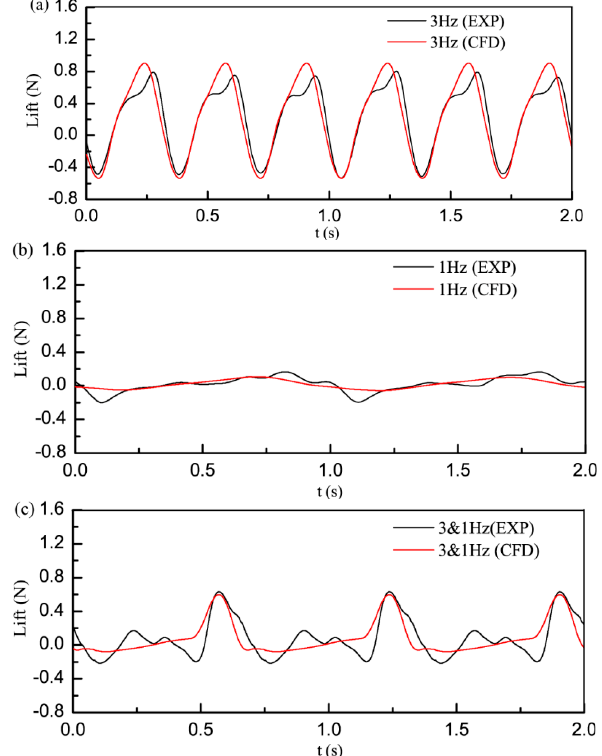
Figure 13. Lift force comparison between the experiment and CFD in ( a ) 3 Hz case; ( b ) 1 Hz case; ( c ) 3&1 Hz case.